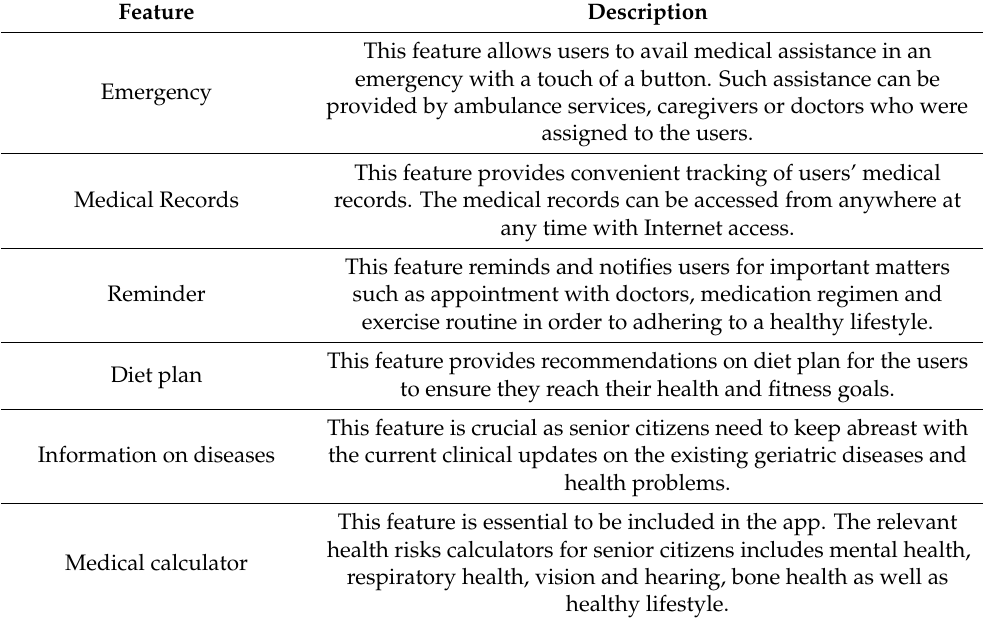
Table 5. The health management